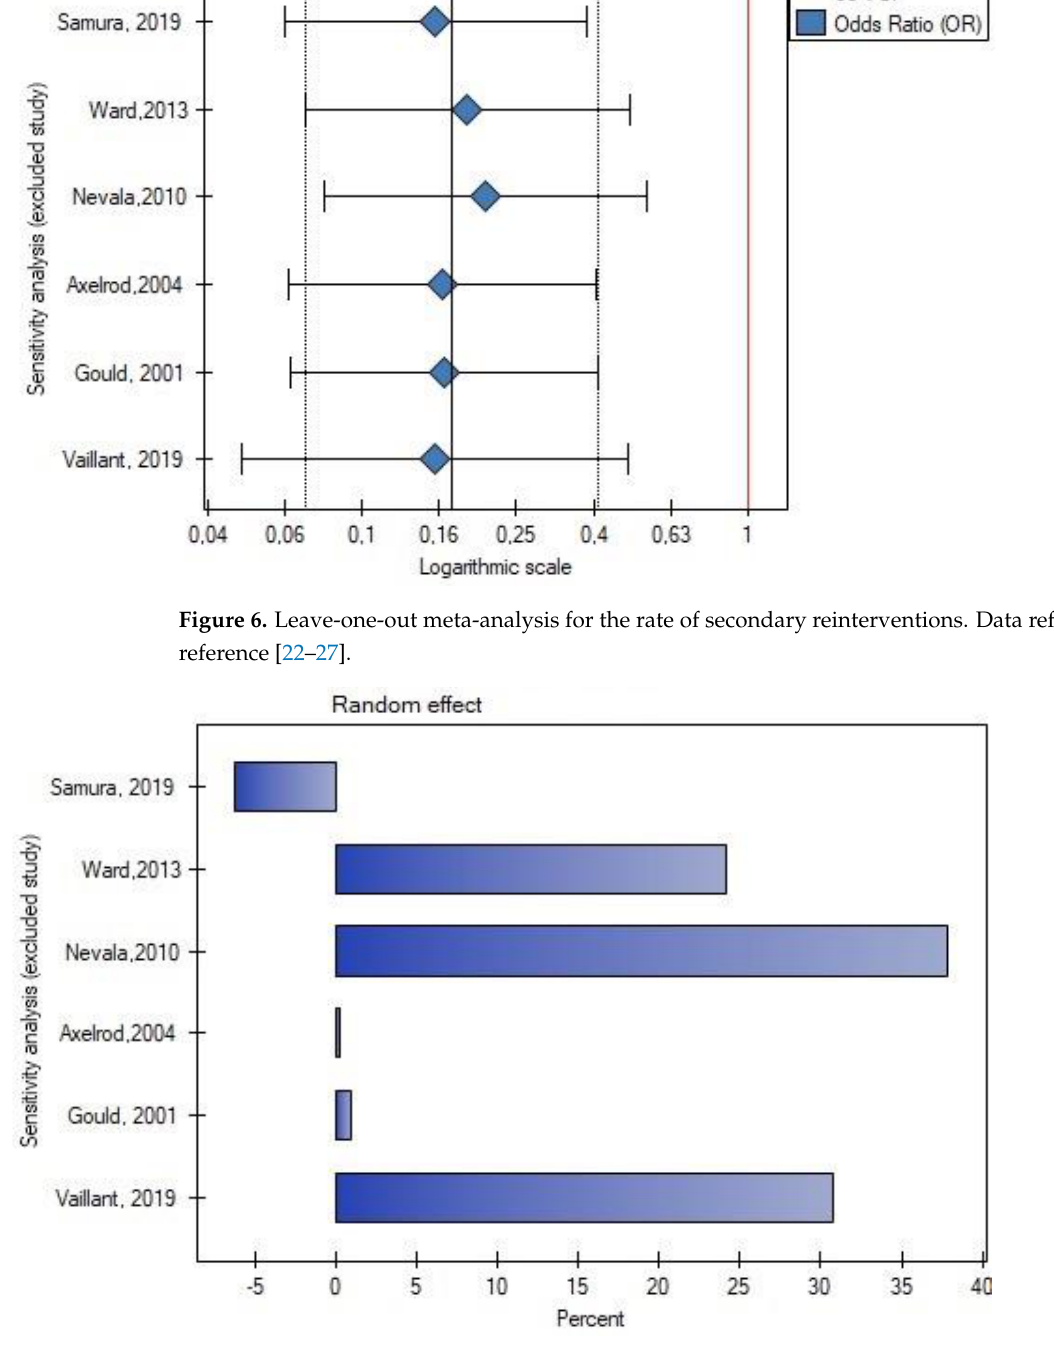
Figure 7. Leave-one-out meta-analysis with random effect and change of precision for the rate of secondary reinterventions. Data referred from reference [22 – 27].